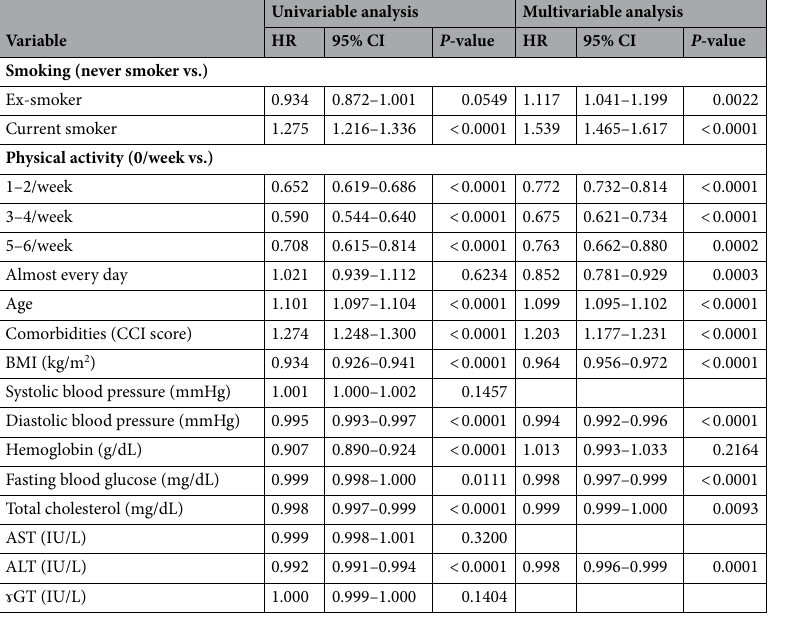
Table 2. Cox regression analyses for COPD development in males. ALT alanine aminotransferase, AST aspartate aminotransferase, BMI body mass index, CCI Charlson’s comorbidity index, CI confidence interval, COPD chronic obstructive pulmonary disease, HR hazard ratio, ɤ GT gamma-glutamyl